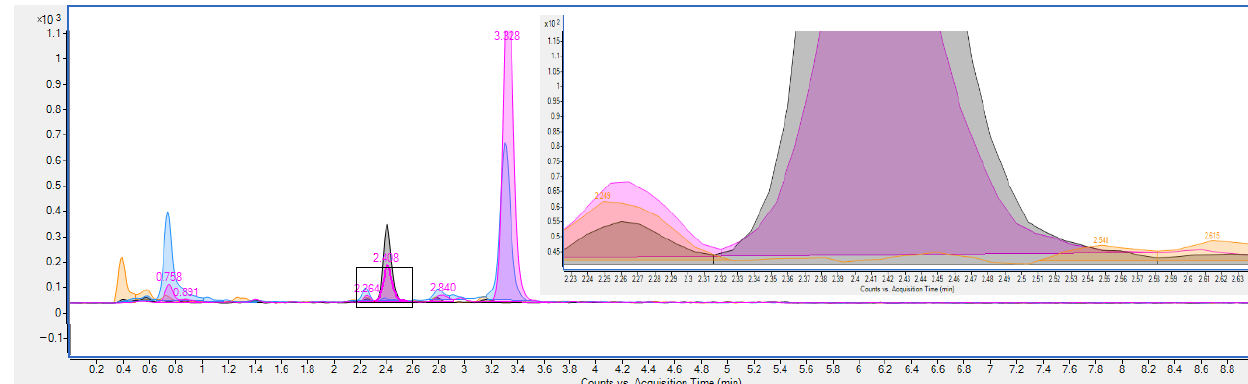
Figure 2. Blank (blue 701.5/255.4 and gold 706.5/255.4) and LLOQ (magenta 701.5/255.4 and grey 706.5/255.4) sample chromatograms.